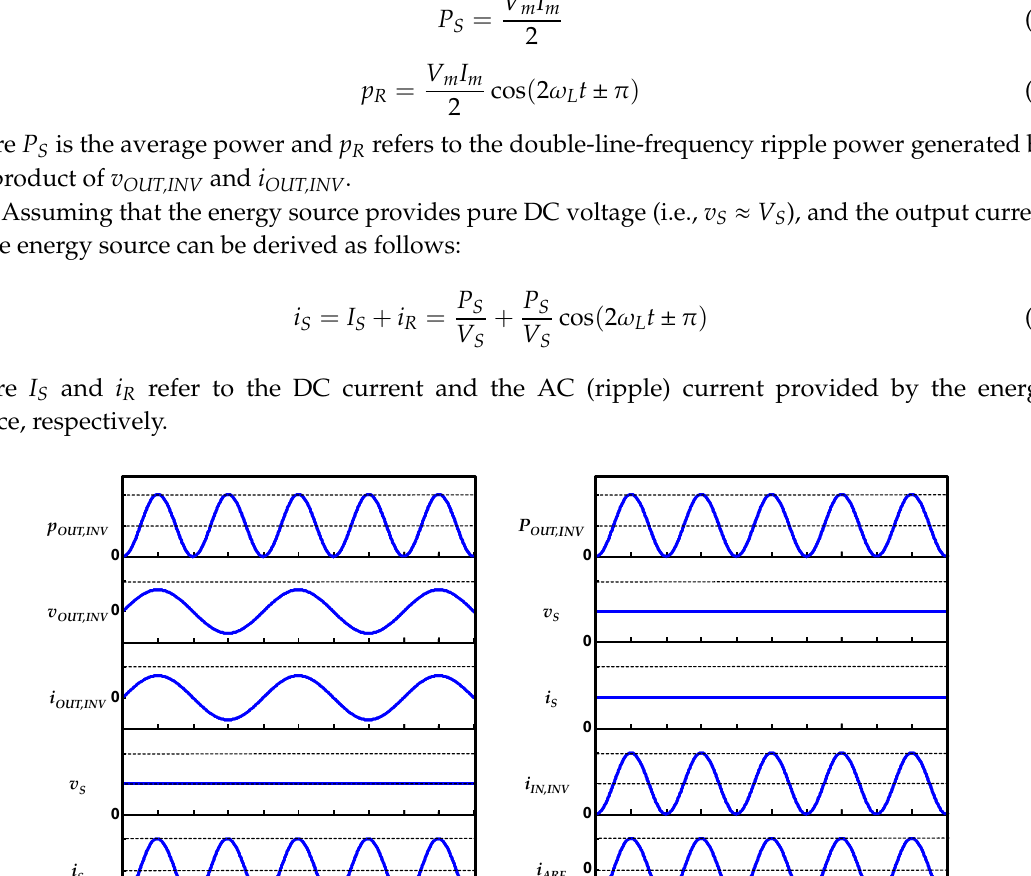
Figure 3. Key waveforms to illustrate the operating principles for double-line-frequency components of a single-phase DC/AC conversion system [26]: ( a ) without the ARF and ( b ) with the ARF.